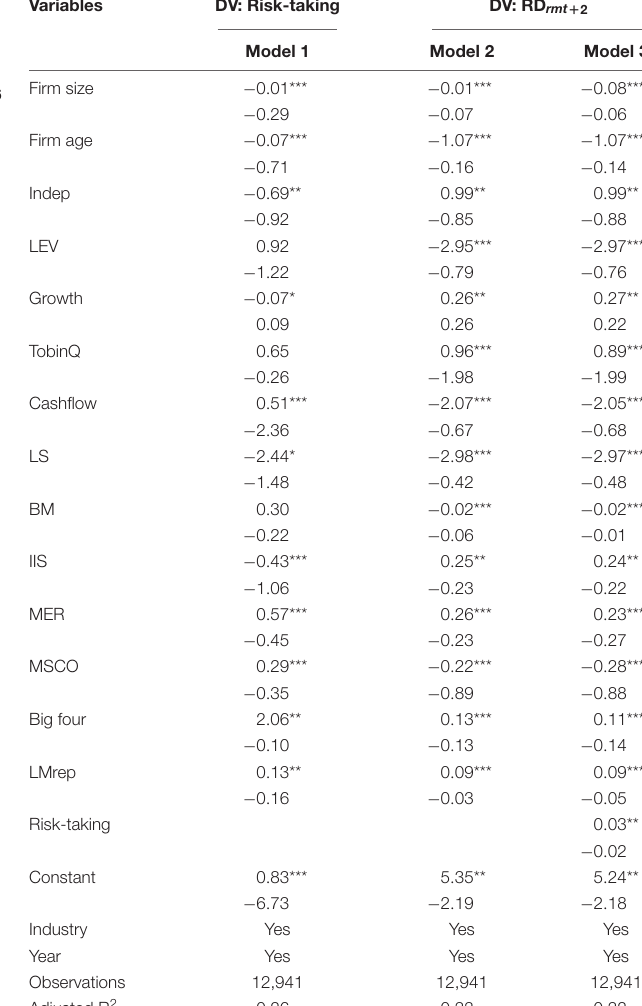
TABLE 6 | Robustness test: managerial reputation, corporate governance, and innovation investment. Variables